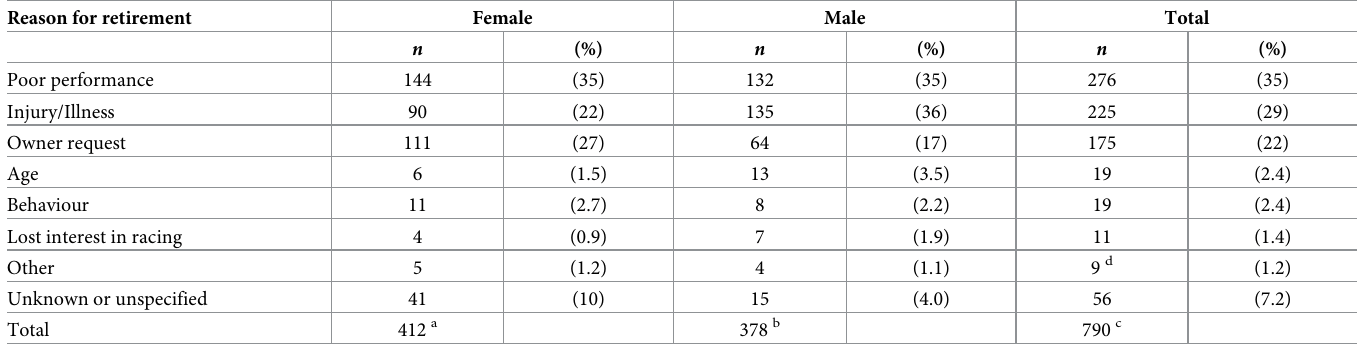
a A total of 412 responses from 408 surveys: Four surveys with multiple responses (poor performance and behaviour ( n = 1), injury/illness and behaviour ( n = 1), injury/ illness and lost interest in racing ( n = 1), behaviour and other ( n = 1) b 378 responses from 372 surveys: Six surveys with multiple responses (poor performance and behaviour ( n = 1), owner request and injury/illness ( n = 1), poor